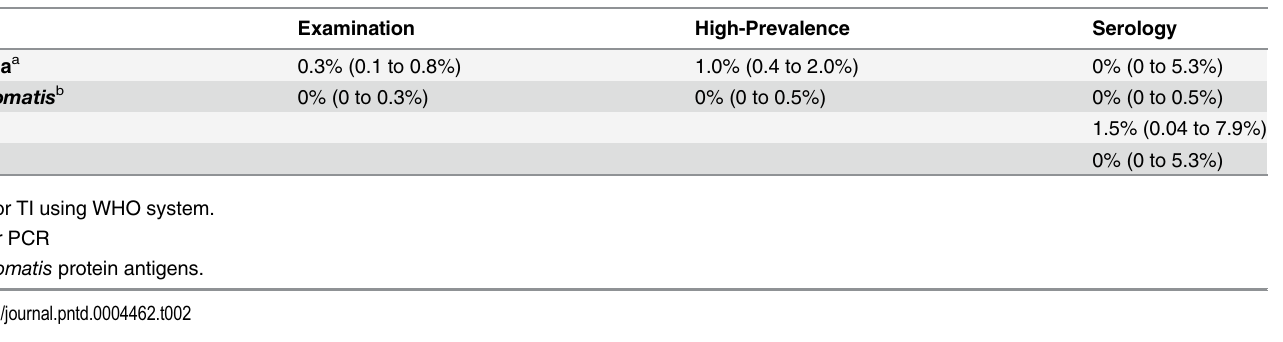
Table 2. Prevalence of trachoma, infection and antibodies against C . trachomatis protein antigens in examination, high-prevalence and serology arms. Community means with 95%